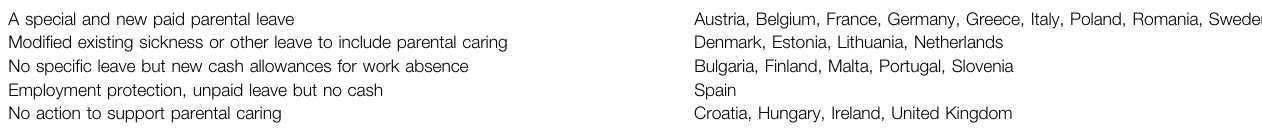
TABLE 1 | Countries Classi fi ed on the Basis of their Response to Parental Caring for Children in Response to the First Periods of COVID-19 in